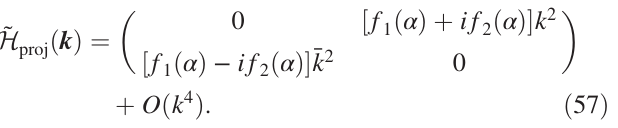
FIG. 8. The wave function ψ model Eq. (59) at the magic angle. The orange points signify zeros of the wave